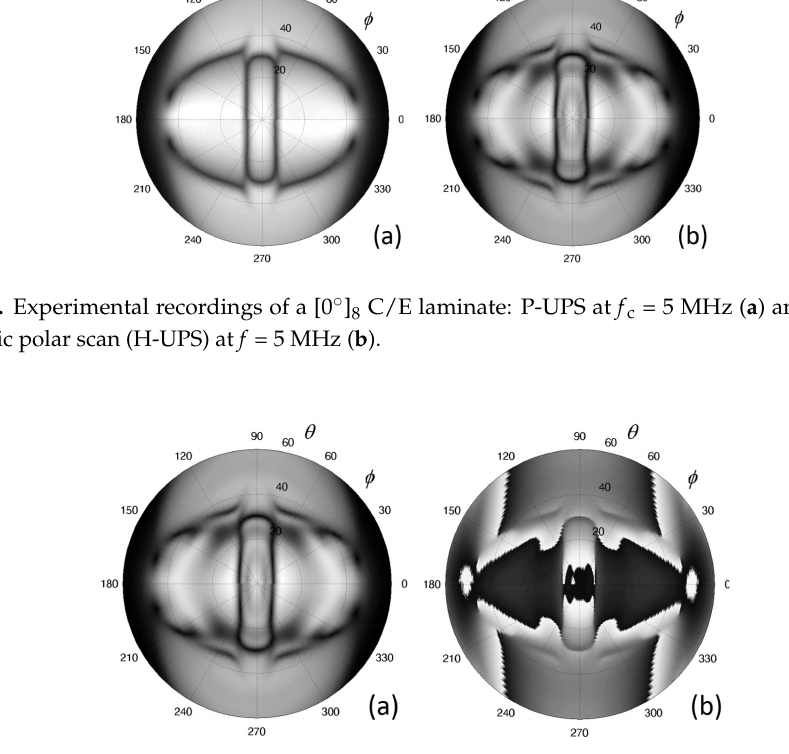
Figure 7. H-UPS recordings for [0 ˝ ] 8 carbon/epoxy laminate at f = 5 MHz: amplitude ( a ) and phase ( b ) analysis.